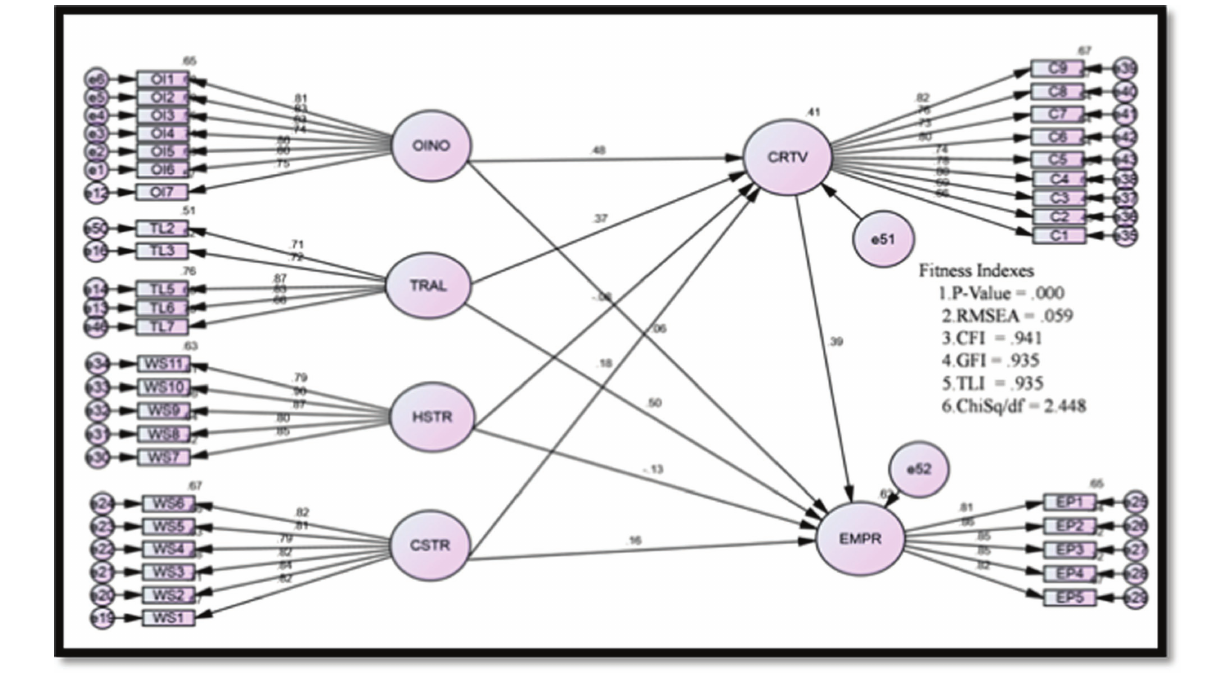
FIGURE 1 | Structural